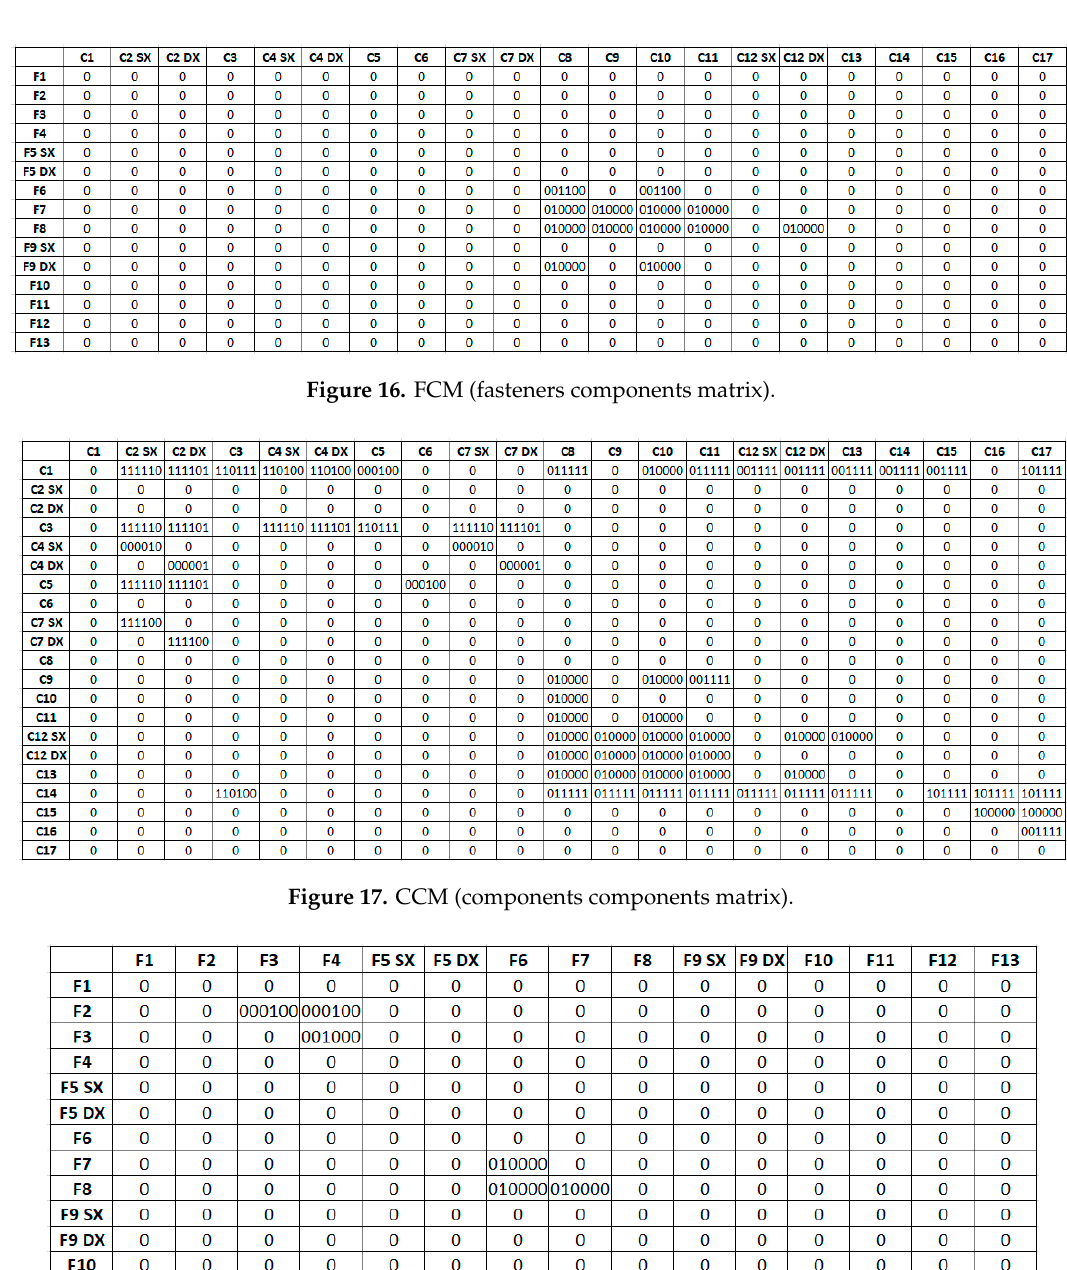
Figure 15. CFM (components fasteners matrix).